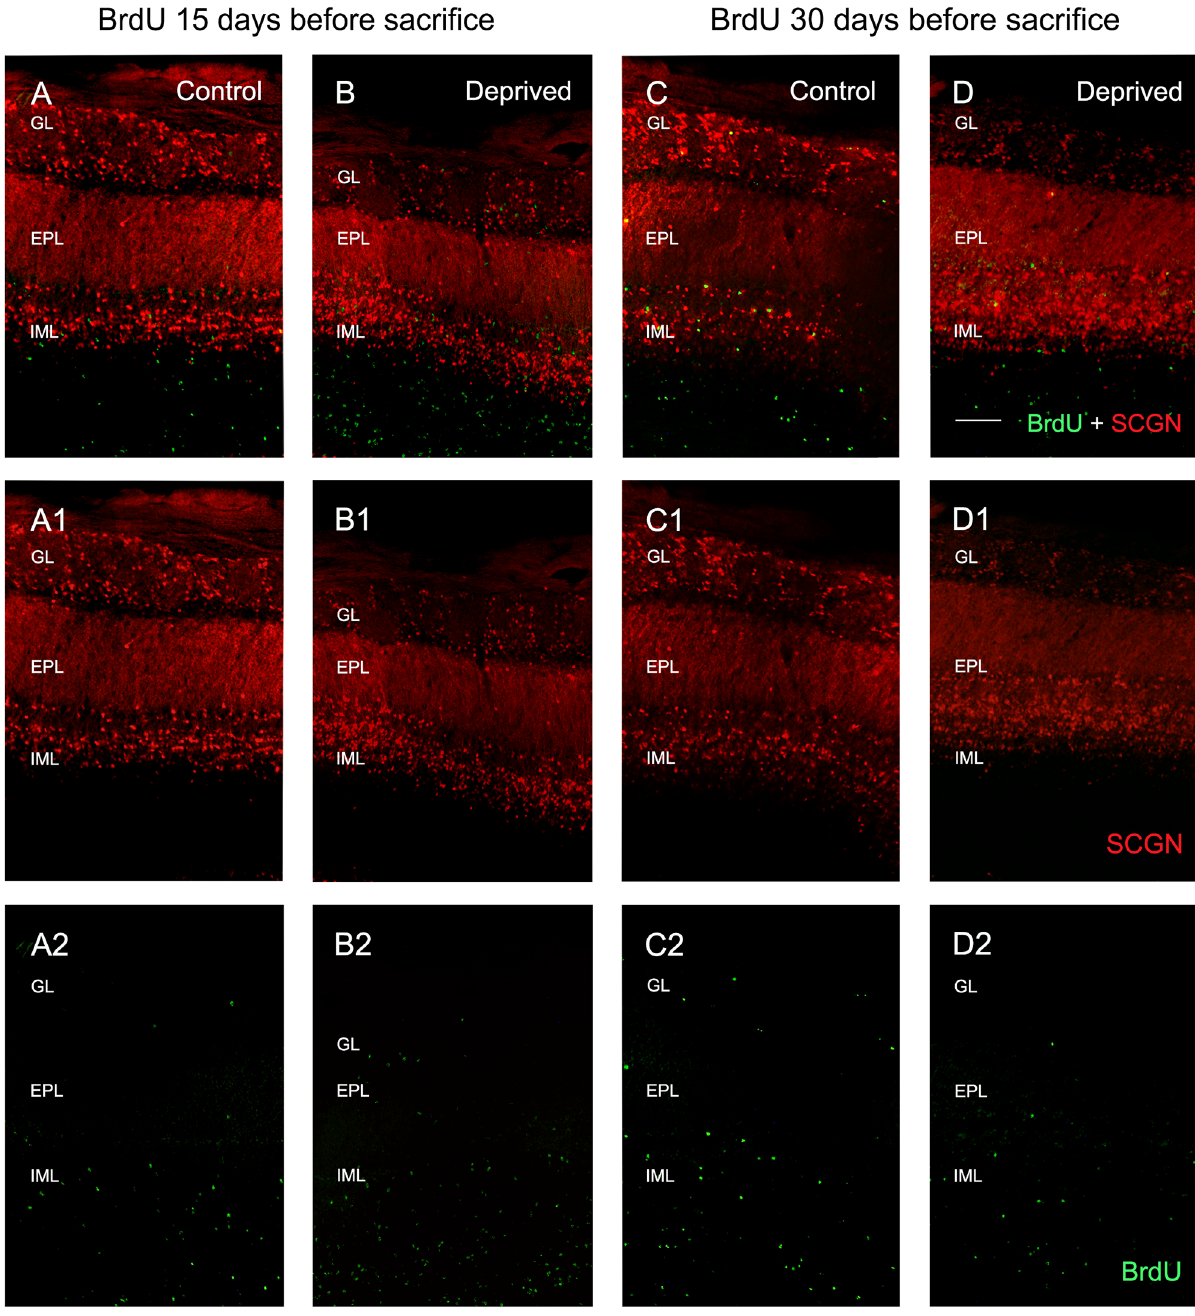
Figure 4. BrdU (green) and SCGN (red) expression in the OB of control ( A , C ) and deprived ( B , D ) mice. The separate channels are also shown for SCGN ( A1 – D1 ) and BrdU ( A2 – D2 ). Colocalization is scarce when BrdU is injected 15 days before the sacrifice of animals ( A , B ), and BrdU-positive cells are mainly found in the innermost OB layers. The analyses of BrdU injection 30 days before sacrifice show an increase in BrdU-positive cells, but BrdU-SCGN colocalization is also extremely low in both control and deprived animals ( C , D ). GL glomerular layer, EPL external plexiform layer, IML inframitral layers. Scale bar 100 marker was used, since monitoring its expression levels has been established as a reliable technique to identify neural populations of metabolically activated brain regions 26,27 . In the control mice, c-Fos-positive cells were only found in the periependymal white matter (n = 6; Fig. 6A). More specifically, c-Fos expression occasionally appeared in clusters of cells in the most caudal level, and only in some of the sections analyzed. Regarding their morphology, these c-Fos-positive cells of the periependymal white matter, when also co-expressed SCGN, presented large nuclei and scarce cytoplasm (Fig. 6A). By contrast, the other experimental groups showed c-Fos expression in all strata, especially in the GL and inframitral layers,